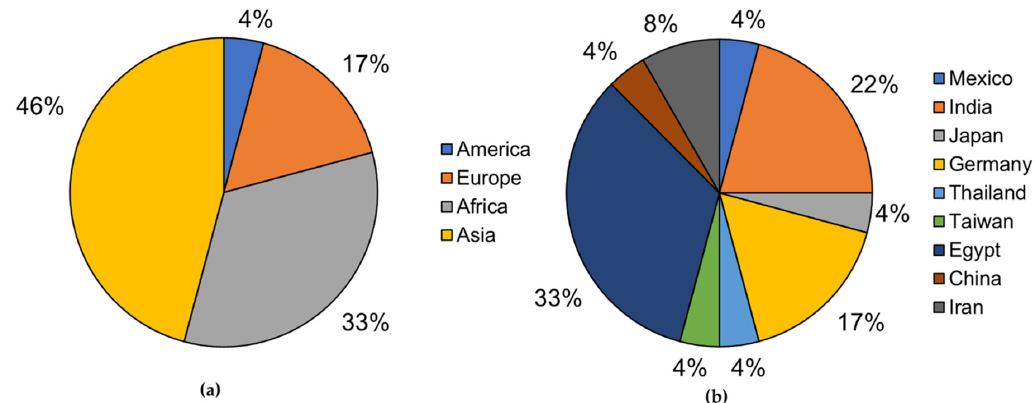
Figure 2. Main isolation countries for Streptomyces strains capable of plastic biodegradation: ( a ) Isolated strains’ percentage by continent; ( b ) isolated strains’ percentage by